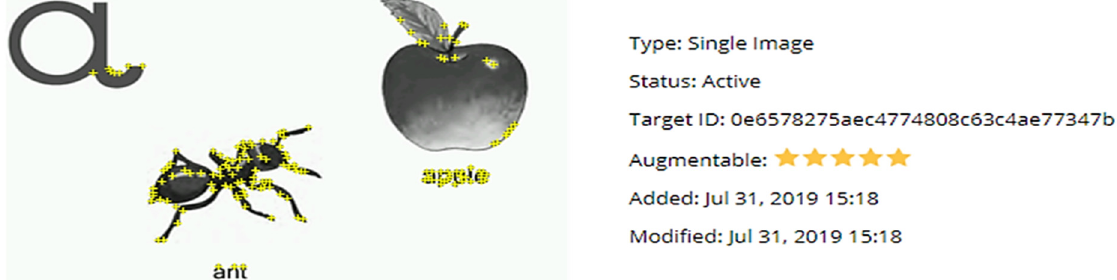
Figure 3. Feature points in image targets that are used by the Vuforia engine to recognize predefined targets.